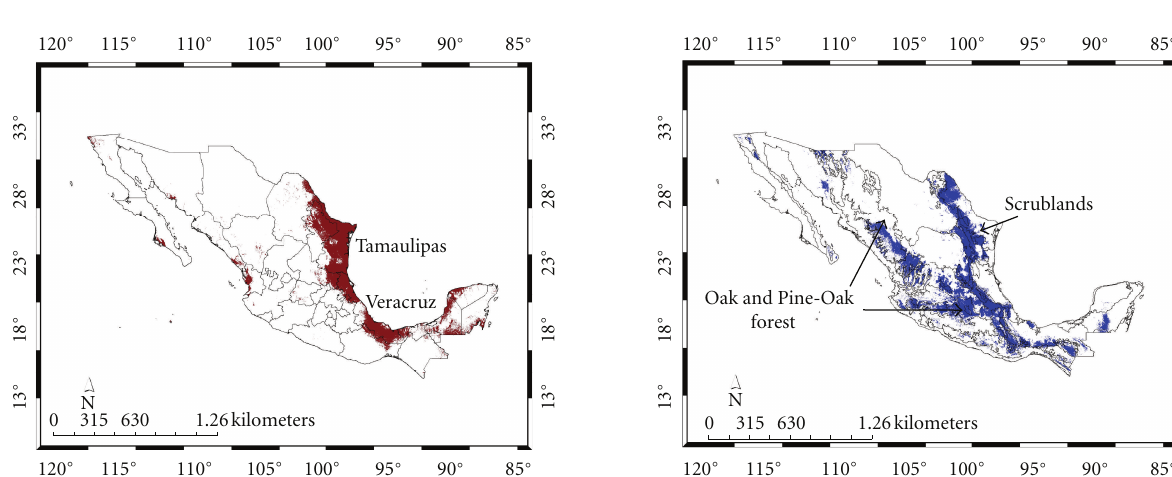
Figure 7: Species distribution model and ecoregions for the Ixodes group. The principal ecoregions are shown (see text).